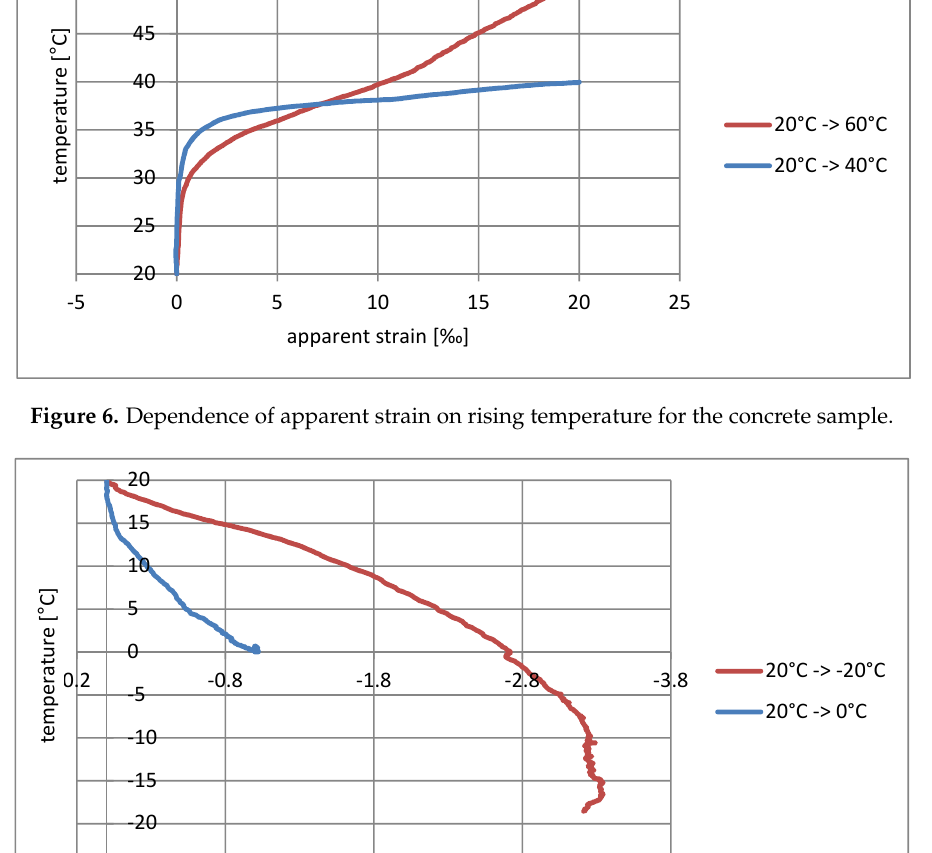
Figure 7. Dependence of apparent strain on decreasing temperature for the concrete sample.